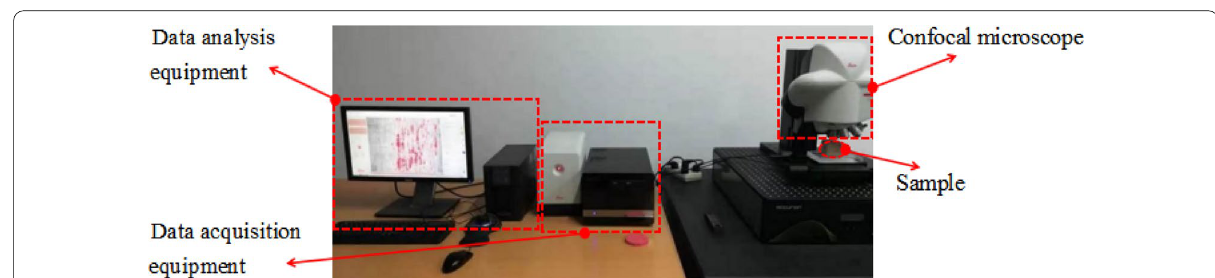
Fig. 8 The scanning system of Leica 3D confocal